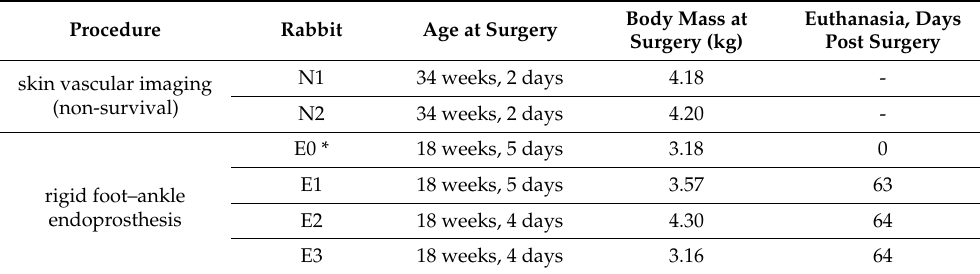
Table 1. Information about rabbits used in the study.